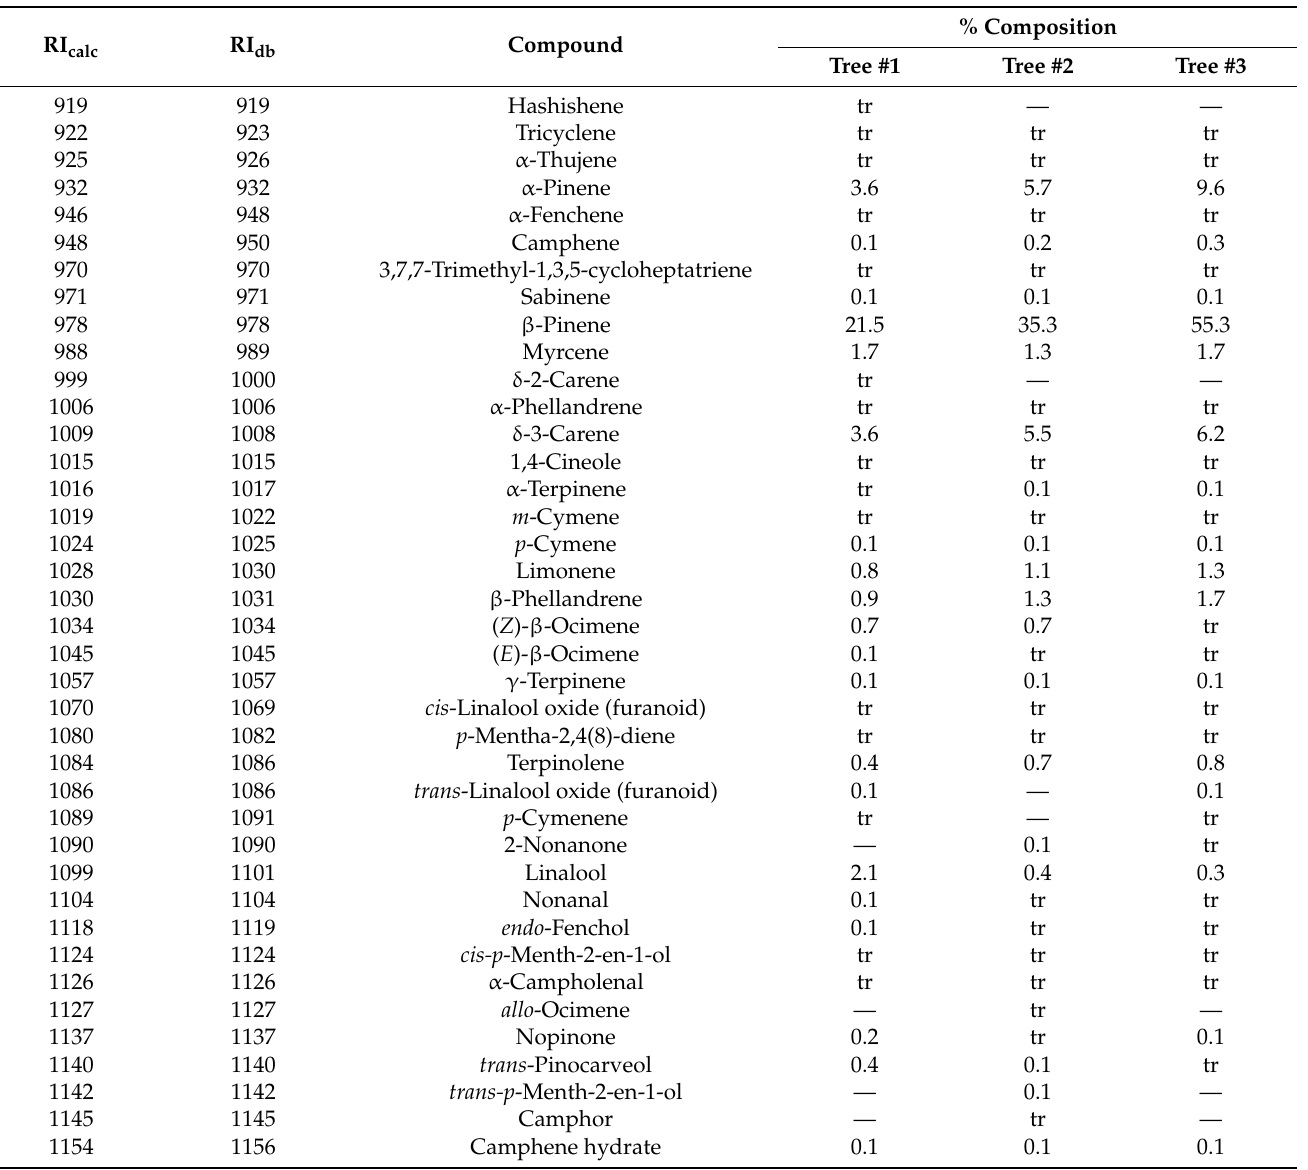
Table 1. Chemical composition of Pinus ponderosa var. ponderosa leaf essential